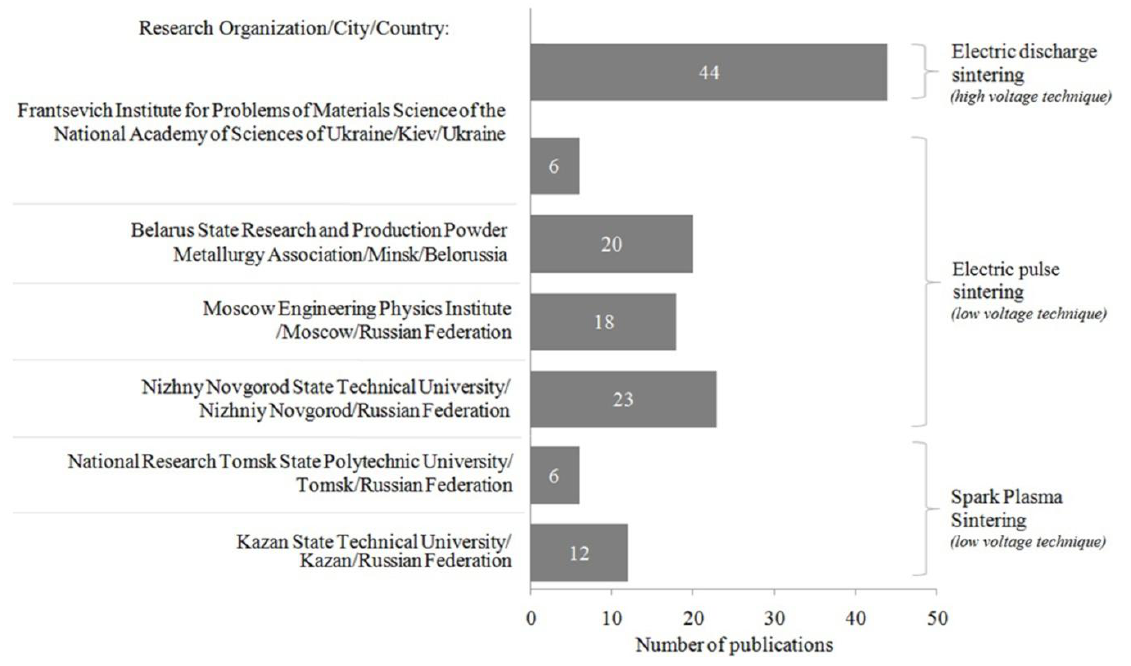
Figure 3. Publications distributed over different research organizations and methods of electric current-assisted